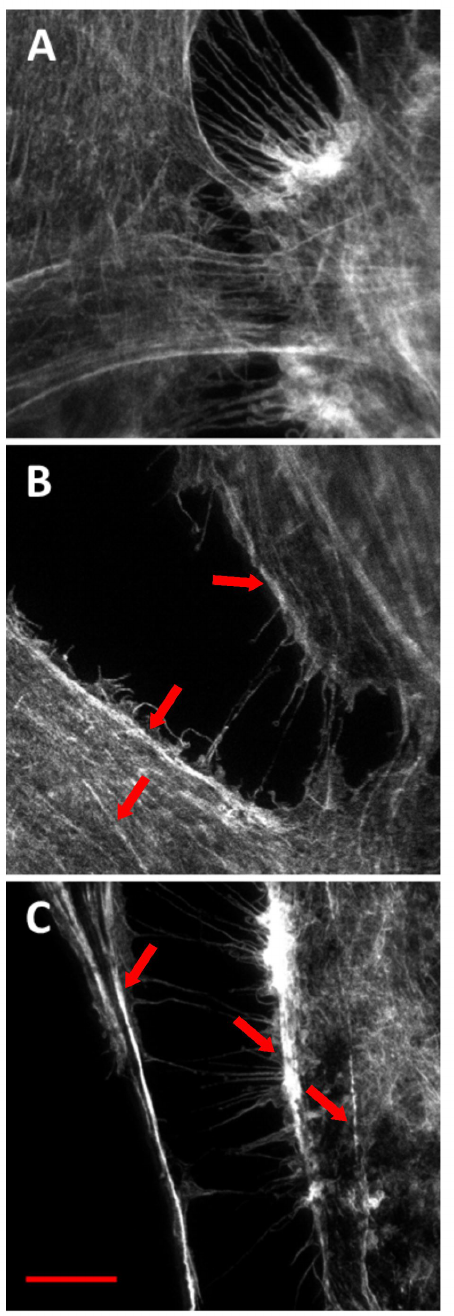
Figure 5. The actin cytoskeleton of HMEC-1 cells was assessed with phalloidin staining (( A )—control cells; ( B )—cells after 24 h incubation with bio SiO 2 ; ( C )—cells after 24 h incubation with pyrSiO 2 ). Samples were imaged using the STED technique. Scale bar: 5 µ m. Red arrows show where phalloidin- positive actin stress fibers are present in the